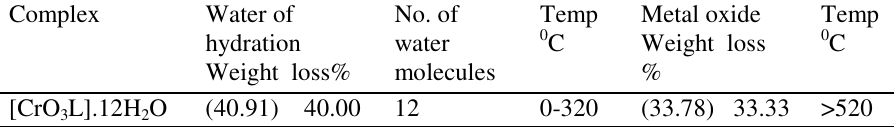
Table 2. Thermogravimetric analysis data of Cr(III) complex